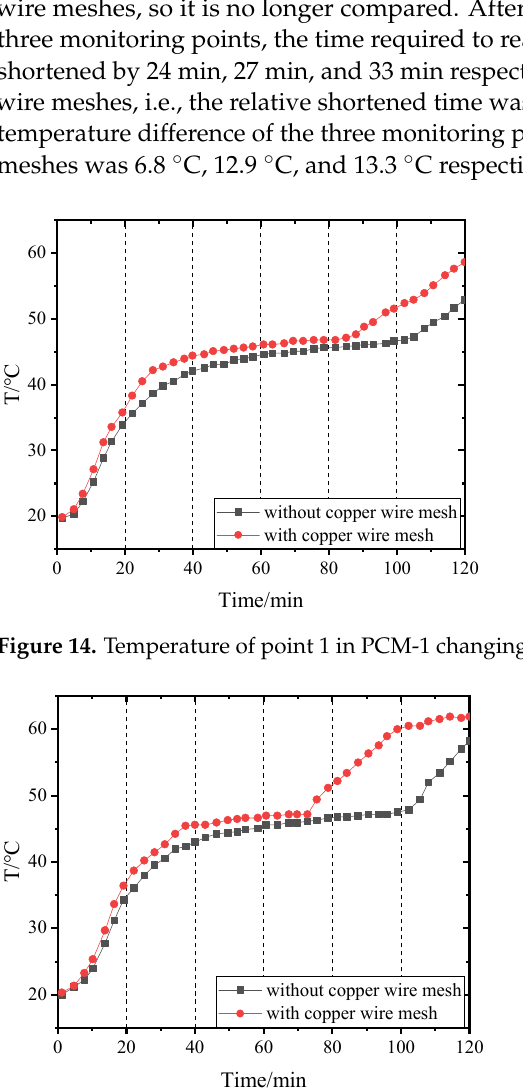
Figure 15. Temperature of point 2 in PCM-1 changing with time.